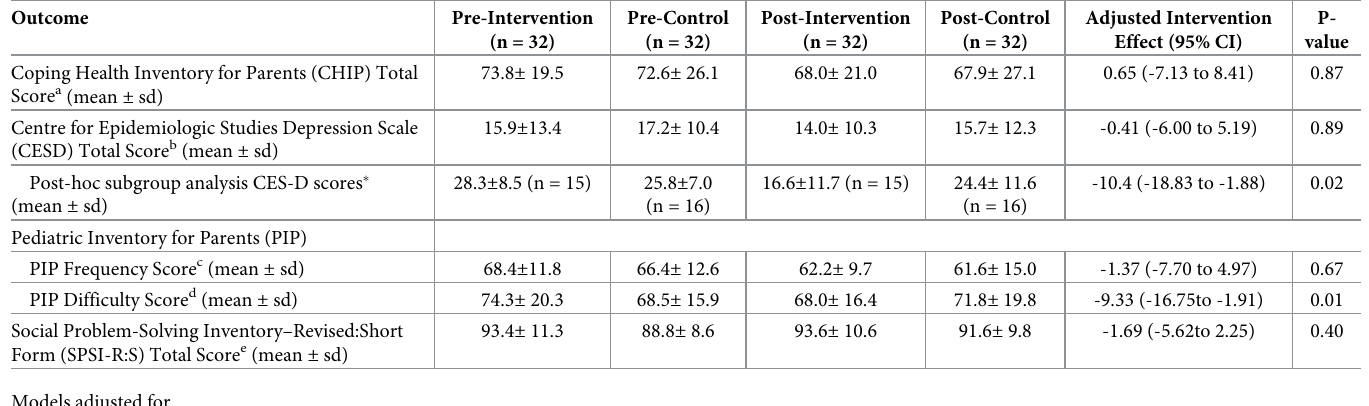
Table 2. Parental psycho-social outcomes